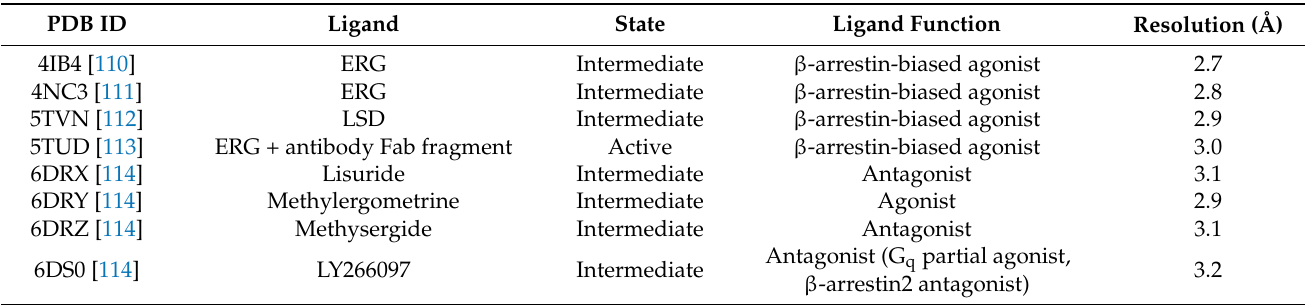
Table 1. Published 5-hydroxytryptamine 2B receptor (5-HT 2B R) crystal structures. PDB